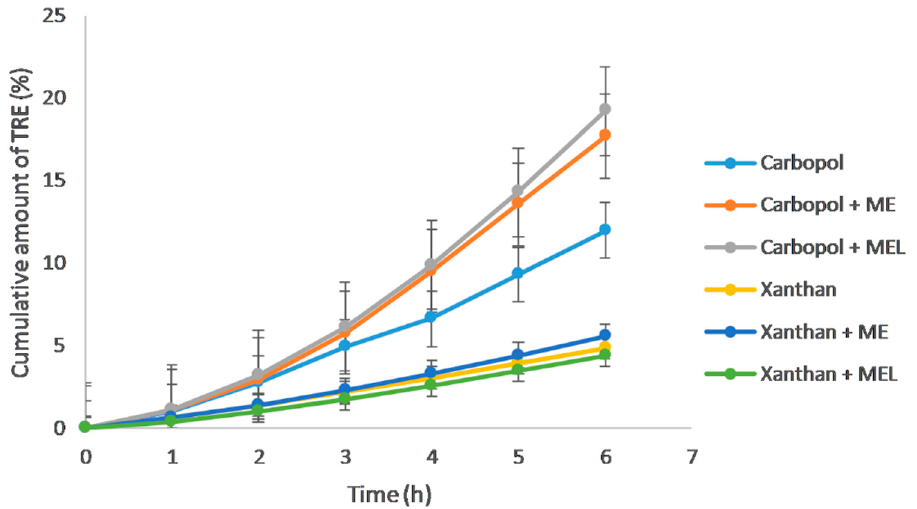
Figure 6. In vitro release of tretinoin from the reference gels, the gels containing the reference microemulsion (ME), or the gels containing the lecithin-containing microemulsion (ME L ) as drug solubilizers via the synthetic membrane ( n = 6).